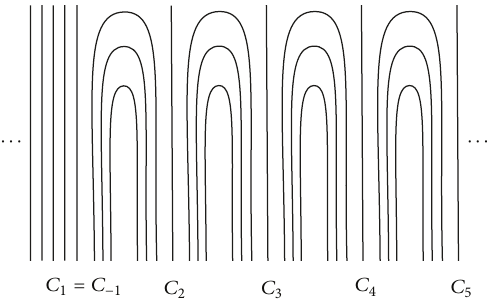
Figure 1: A generalized Reeb flow with 𝐴 − = {−1} and 𝐴 + = 𝐴 +∞ .